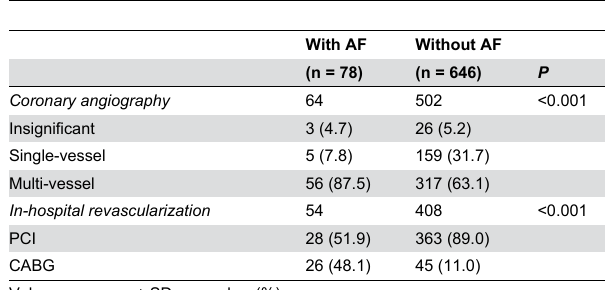
Table 3. Angiographic characteristics and revascularization strategies of patients with and without AF.